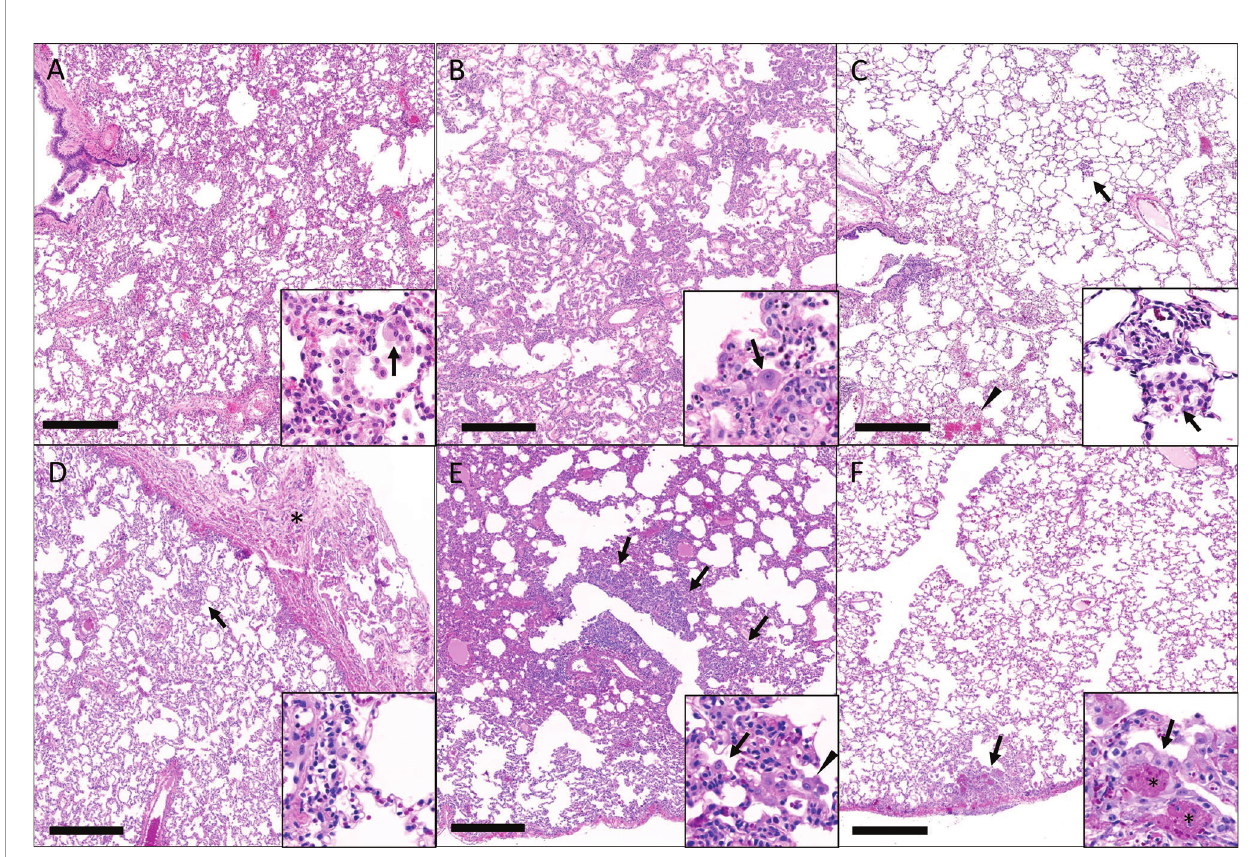
FIGURE 7 | Histopathologic fi ndings in the lungs of rhesus macaques challenged with SARS-CoV-2 following prophylactic administration of combination mAb therapy. (A) Naïve (KF89). There is severe, widespread, interstitial in fl ammation. Inset: The in fl ammatory in fi ltrate is predominantly histiocytic with rare multinucleated cells (arrow). (B) mAb control (IK92). There is severe, widespread interstitial in fl ammation. Inset: Alveolar septa are lined by type II pneumocytes that occasionally exhibit atypia (arrow). (C) Delayed challenge (MC61). There is minimal interstitial in fl ammation with scattered aggregates of in fl ammatory cells (arrow) and hemorrhage (arrowhead). Inset: In fl ammatory cells are predominately histiocytes (arrow). (D) 2 mg/kg (MG10). There is mild interstitial in fl ammation (arrow) and pleuritis (asterisks). Inset: The interstitial in fl ammation is perivascular and composed of low numbers of lymphocytes and histiocytes. (E) 6 mg/kg (ME55). There are multifocal regions of bronchointerstitial in fl ammation (arrows). Inset: Within areas of in fl ammation there is type II pneumocyte hyperplasia (arrow) and histiocytic in fi ltrate (arrowhead). (F) 20 mg/kg (LR09). There are rare localized areas of subpleural in fl ammation (arrow). Inset: Within theses areas there is type II pneumocyte hyperplasia (arrow) and fi brin (asterisks). Bar = 0.5